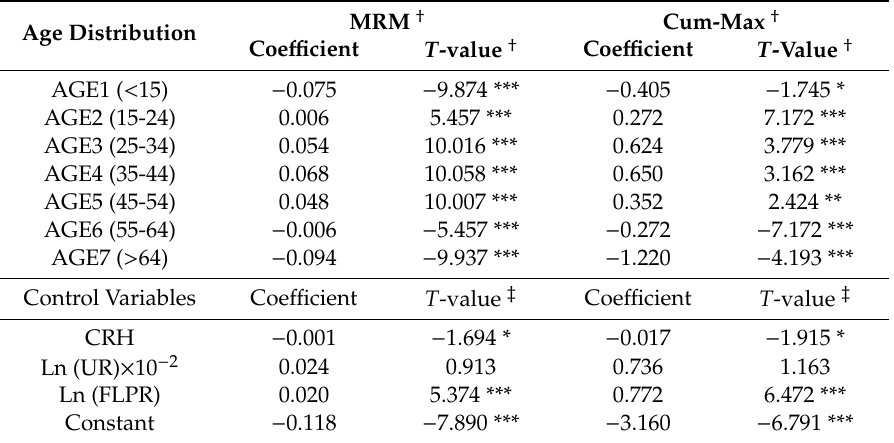
Table 3. E ff ects of age structural transitions on copayment policy e ff